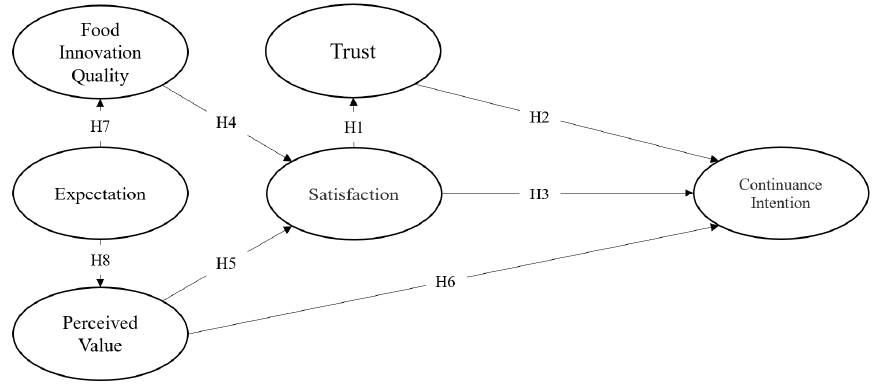
Figure 1. Research structure.